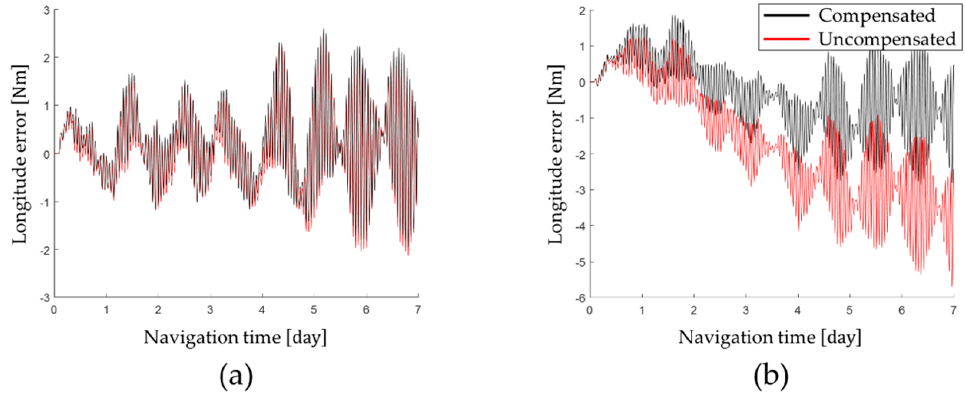
Figure 9. Position error after compensating for gyro bias transition: ( a ) latitude error; ( b ) longitude error.